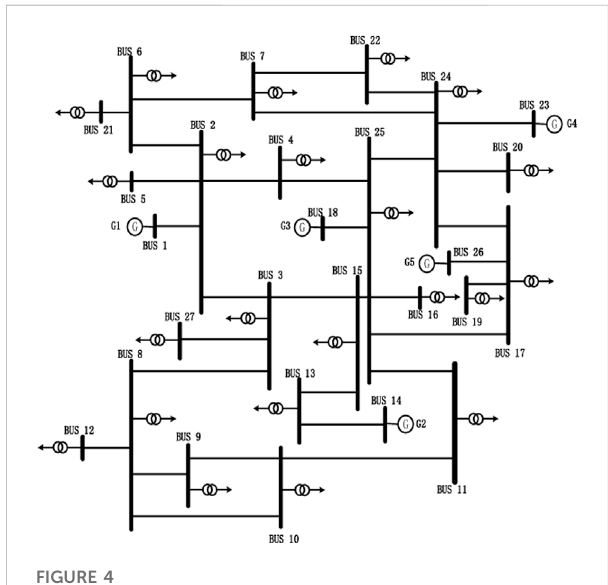
FIGURE 4 Topology diagram of an actual power